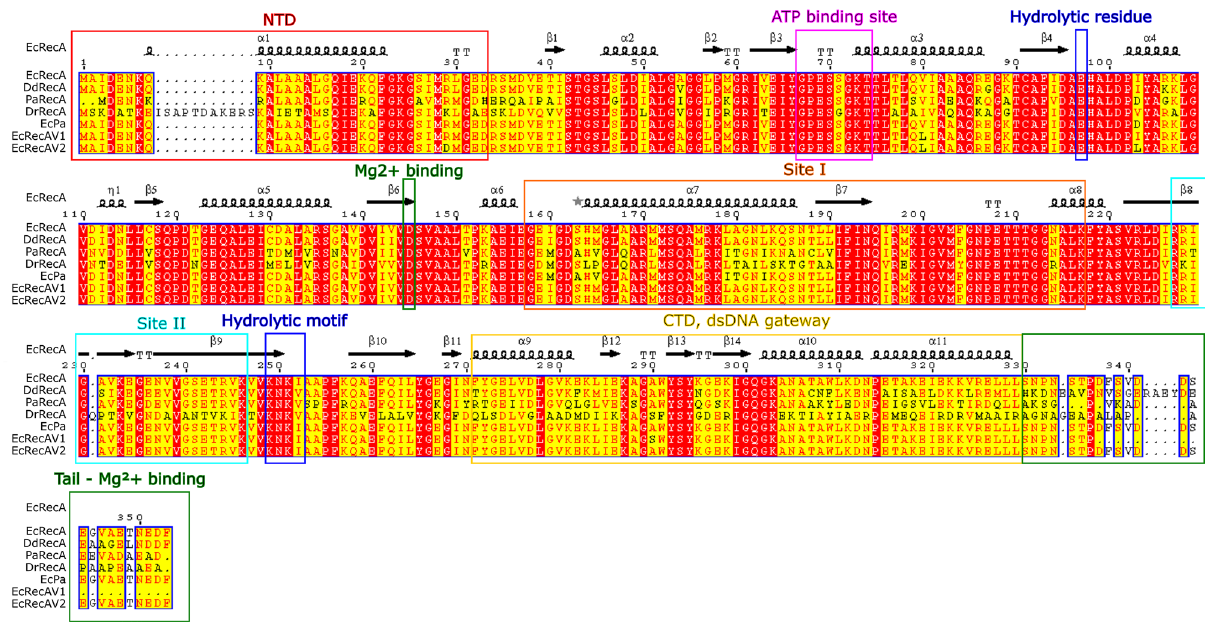
Figure 2. Multialignment of RecA from different bacteria and E. coli RecA variants characterized in the study. The sequences aligned are from the following organisms. AML00775: Escherichia coli str. K-12 substr. MG1655 RecA; WP_038923633: Dickeya dadantii strain 3937 RecA; AAG07005: Pseudomonas aeruginosa PAO1 RecA; and AAF11887: Deinococcus radiodurans R1 RecA. The three E. coli variants EcRecAV1, EcRecAV2 and EcPa were also aligned. The filled red boxes indicate strict identity between residues, and the filled yellow boxes indicate strong homology between residues. No difference is made between black and red characters in this case because this feature is applied for other usages. At the top of the first sequence, the 2D structure of E. coli RecA is shown: the squiggles represent α-helices; the arrows, β-strands; the TT letters, strict β-turns; and the star, a residue with multiple conformations revealed by crystallography. The 2D structure is from the PDB entry 4TWZ. Additionally, the different domains of RecA are indicated in boxes: in red, the N-terminal domain (NTD); in pink, the ATP binding site; in blue, the hydrolytic residue and the hydrolytic motif; in orange, site I; in cyan, site II; in yellow, the dsDNA gateway in the CTD; and in green, the C-tail and the Mg 2+ binding sites. The first methionine is present in the alignments to allow the program to perform well. Thus, the numbering of each amino acid is shifted by one in the figure compared to the text. For example, in EcRecA, L29 is in the 30 th position in the figure. The figure was generated using the ENDscript server 27